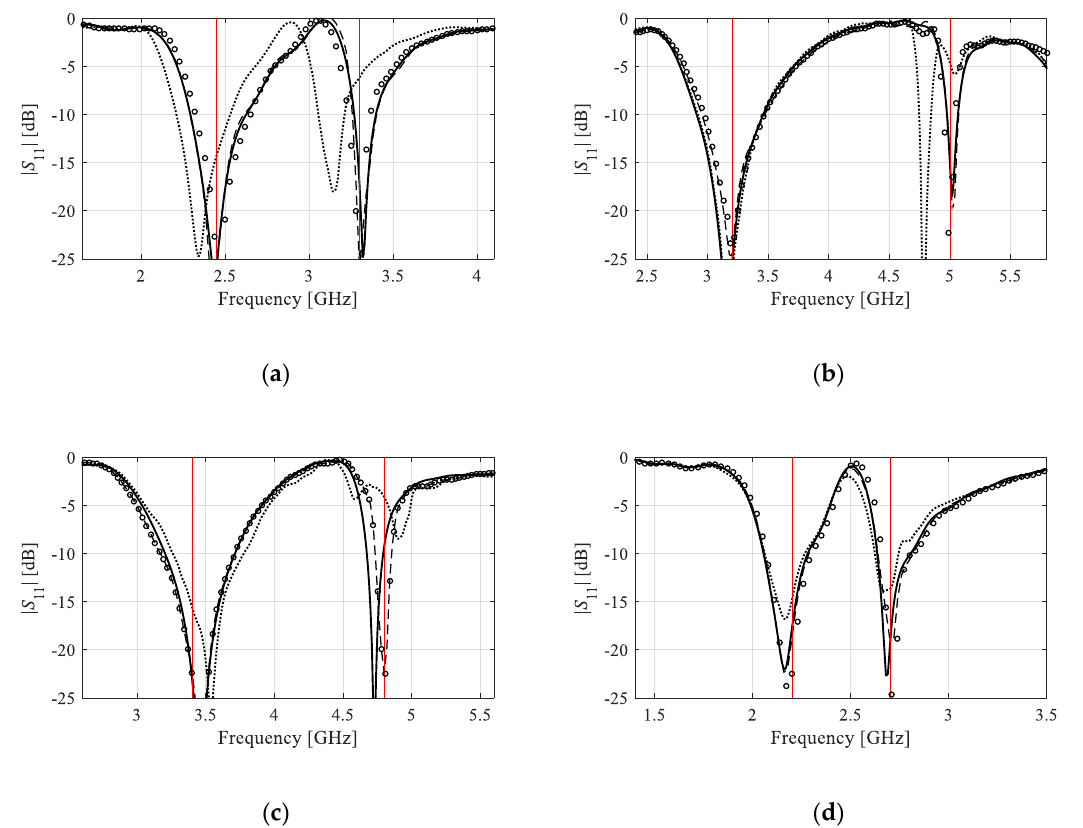
Figure 9. Optimization of the antenna of Figure 6 using the variable-thickness nested kriging surrogate for the four pairs of operating frequencies: ( a ) f 1 = 2.45 GHz, f 2 = 3.3 GHz, ( b ) f 1 = 3.2 GHz, f 2 = 5.0 GHz, ( c ) f 1 = 3.4 GHz, f 2 = 4.8 GHz, ( d ) f 1 = 2.2 GHz, f 2 = 2.7 GHz. Shown are: the initial design obtained from the first-level kriging model ( ···· ), response of the optimized variable-thickness nested kriging surrogate (- - -), response of the optimized fixed-thickness surrogate (o), and EM-simulated antenna response at the variable-thickness surrogate model optimum